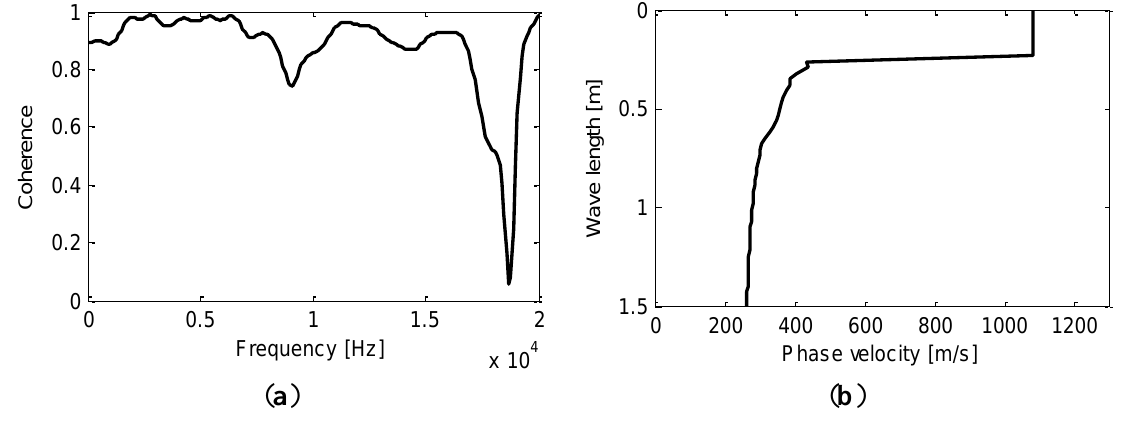
Figure 15. ( a ) Coherence function; and ( b ) Dispersion curve.